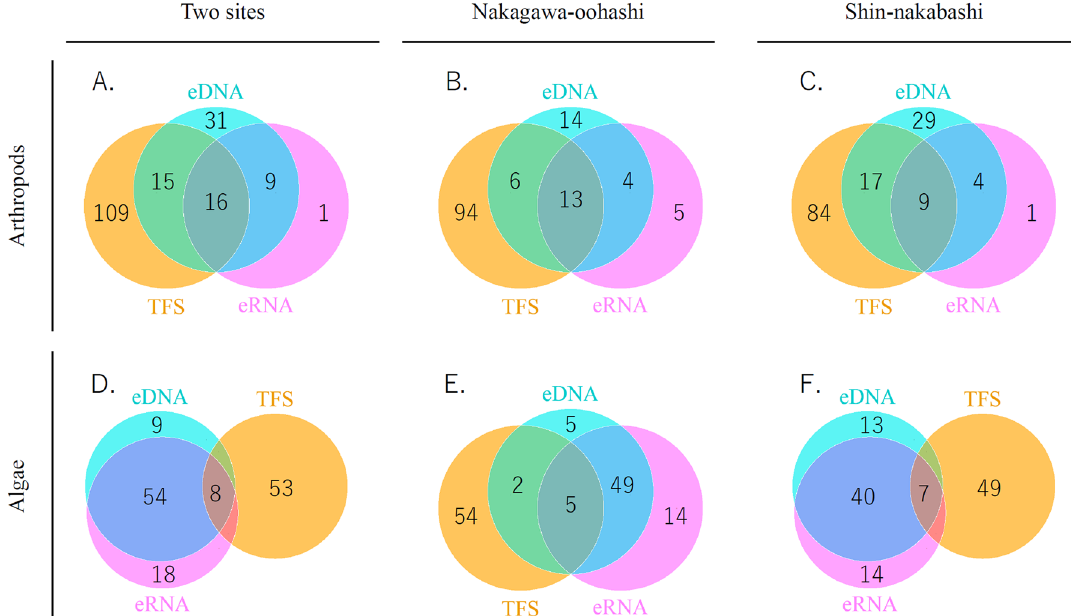
Figure 2. Comparison of the species detected using the eDNA/eRNA metabarcoding analyses and traditional field surveys (TFSs). ( A–F ) Comparison of the species detected using eDNA/eRNA metabarcoding and TFS. Venn diagrams were illustrated for multiple analytical conditions in a matrix (species vs. sites). For example, ( A ) indicates a result using two-site merged data in arthropods, and ( E ) uses data only from Nakagawa-oohashi for